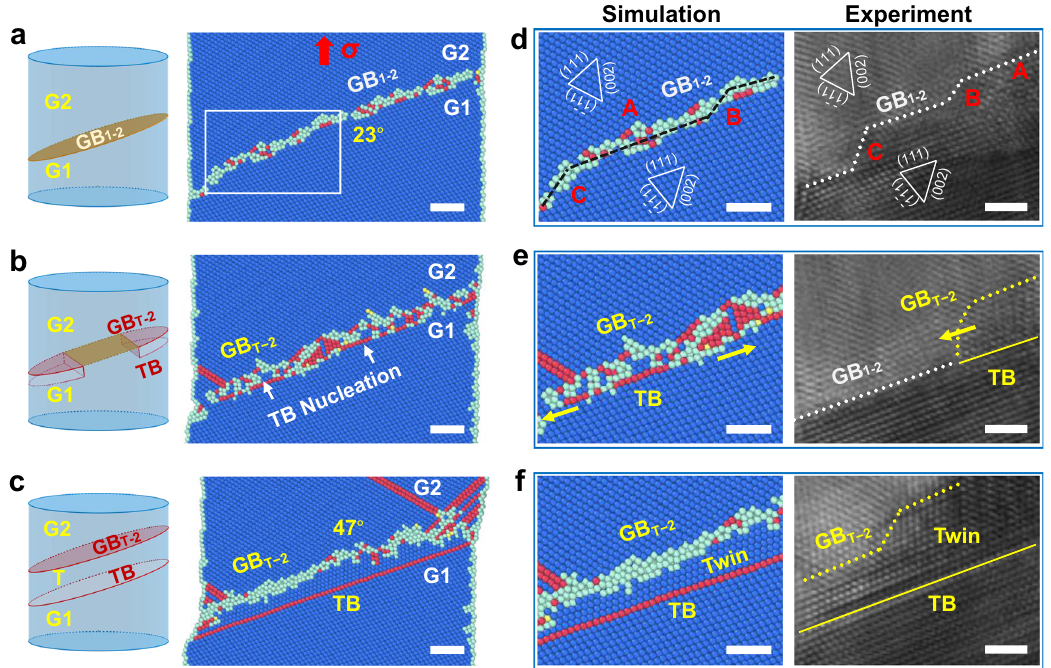
Fig. 2 Atomistic dynamics of GB-mediated deformation twinning. a MD simulation performed on an inclined 23° tilt GB under uniaxial tensile loading, clearly validating the twinning-assisted GB structure adjustment . b Embryonic deformation twins nucleated from the GB, tuning the local GB 1 – 2 segments to GB T-2 . c Growth of the deformation twin via the interlink of TB segments, resulting in a perfect coherent TB accompanied by a concomitant GB T-2 with a tilt angle of 47°. Left schematic insets of ( a – c ) illustrating the inclined GB con fi gurations in the twinning process. d – f Atomistic simulation and experiment elucidating the detailed twinning process accompanied by the lateral motion of facets along GBs. d The initial GB 1 – 2 contained typical GB facets B and C, as well as the main terrace A, which possessed the same misorientation but different inclinations. e Preferential twinning occurred at terrace A, while the remaining minor facets B and C moved laterally along the GB. Yellow arrows indicate the direction of twin growth. f Embryonic twin expanded along terrace A, resulting in a perfect coherent TB with a comparatively fl at concomitant GB T-2 . Atoms with face-centered cubic (FCC), hexagonal close-packed (HCP) and disordered structures were coloured in blue, red and cyan. All scale bars: 2